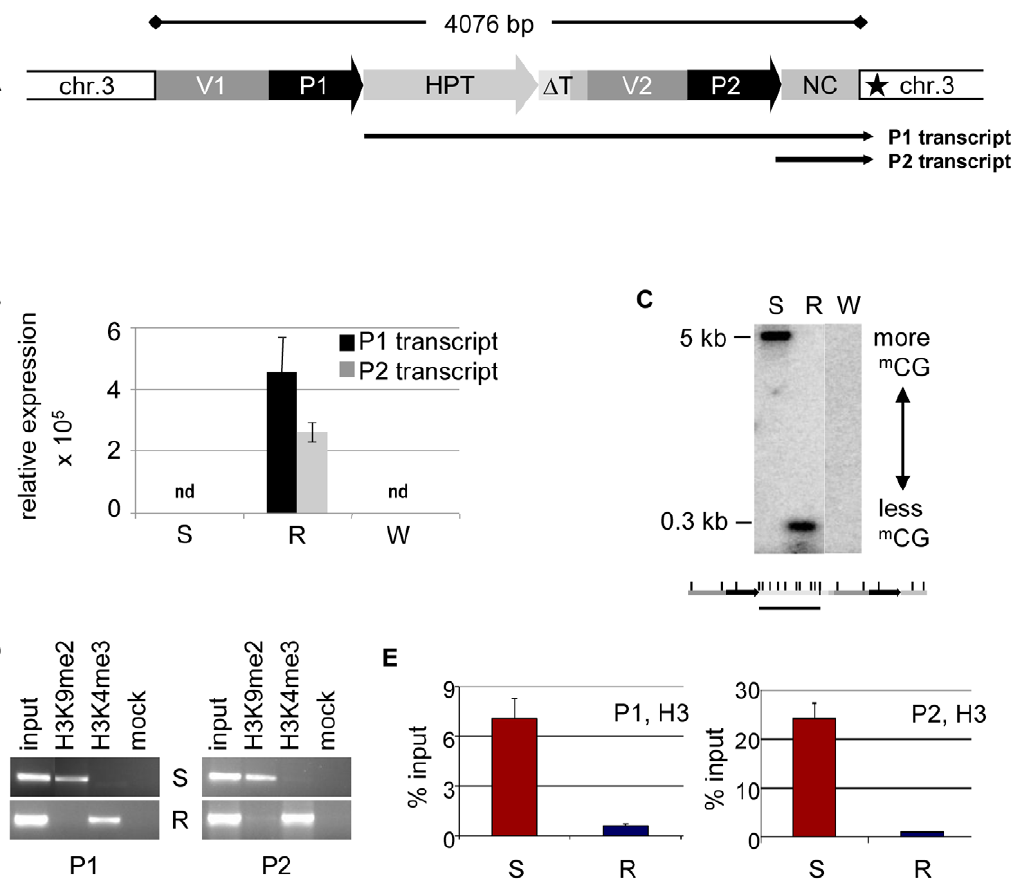
Figure 1. Epialleles differ in chromatin features. (A) Transgenic insert (identical in lines S and R) with duplicated vector (V1, V2) and CaMV35S promoter (P1, P2) sequences and single copies of the hygromycin phosphotransferase resistance gene (HPT, P1 transcript), a truncated terminator ( D T) and a non-coding sequence containing bovine carrier DNA (NC, P2 transcript). Black star: polyadenylation signal-like sequence. (B) Transcript levels determined by qRT-PCR in diploid Arabidopsis ecotype Zu¨rich with (S, R) or without (W, wild type) the transgenic insert. P1 was determined with primers within the HPT sequence, P2 with primers within the NC sequence. Due to the overlap, this might capture also some P1 templates. Normalization to S; reference gene EIF4a (At3g13920); error bars represent standard deviation of triplicate measurements. (C) Methylation analysis in three week-old seedlings with (S, R) or without (W, wild type) the transgenic insert. Genomic DNA was treated with Hpa II not cutting m C m CGG, blotted and hybridized to a probe spanning the HPT sequence. Enzyme recognition sites are indicated below the blot. (D, E) Analysis of histone H3 at both promoters (P1, amplicon 133 bp; P2, amplicon 197 bp; primers see Table S4) in lines S and R by chromatin immunoprecipitation. (D) Association with H3K9me2 and H3K4me3; (E) modification-independent